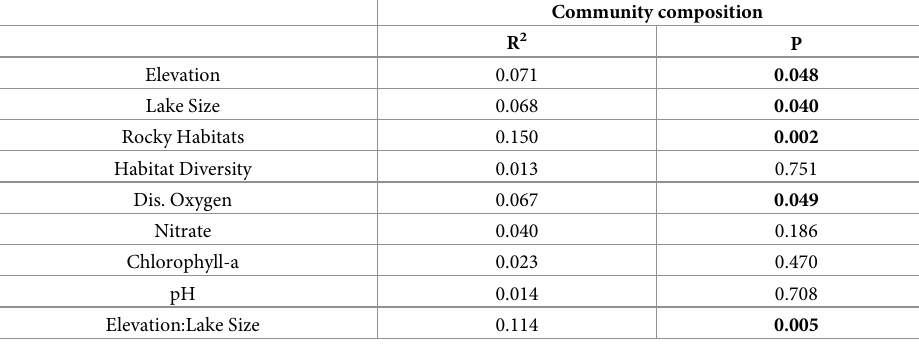
Table 2. Results of permanova, applying Bray-Curtis dissimilarities and running 9,999 permutations to investi- gate the effect of environmental variables on macroinvertebrate community composition in alpine lakes of Hohe Tauern National Park